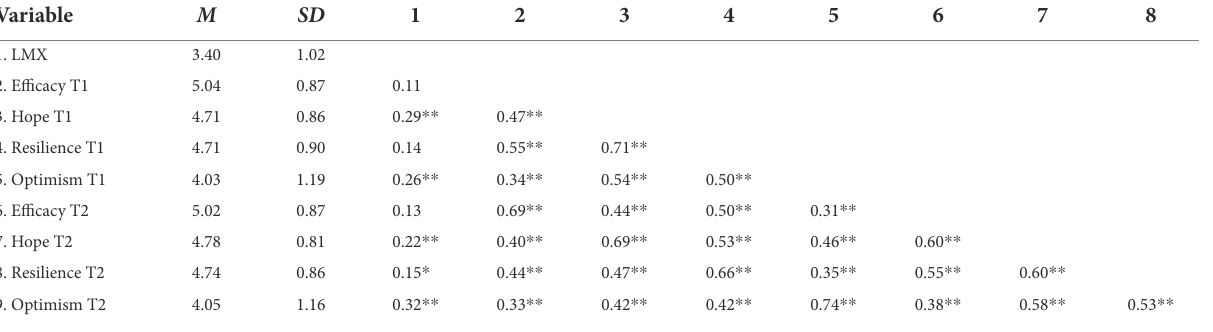
TABLE 1 Means, standard deviations, and correlations. Variable